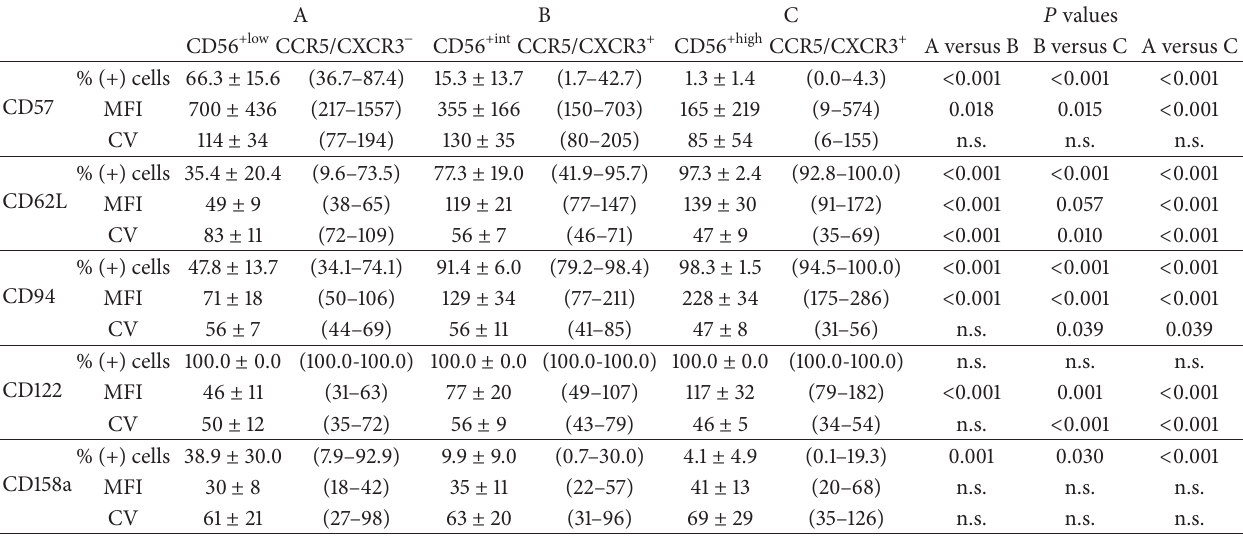
Table 4: CD57, CD62L, CD94, CD122, and CD158a expression on peripheral blood CD56 +low CCR5/CXCR3 − , CD56 +int CCR5/CXCR3 + , and CD56 +high CCR5/CXCR3 + NK-cell